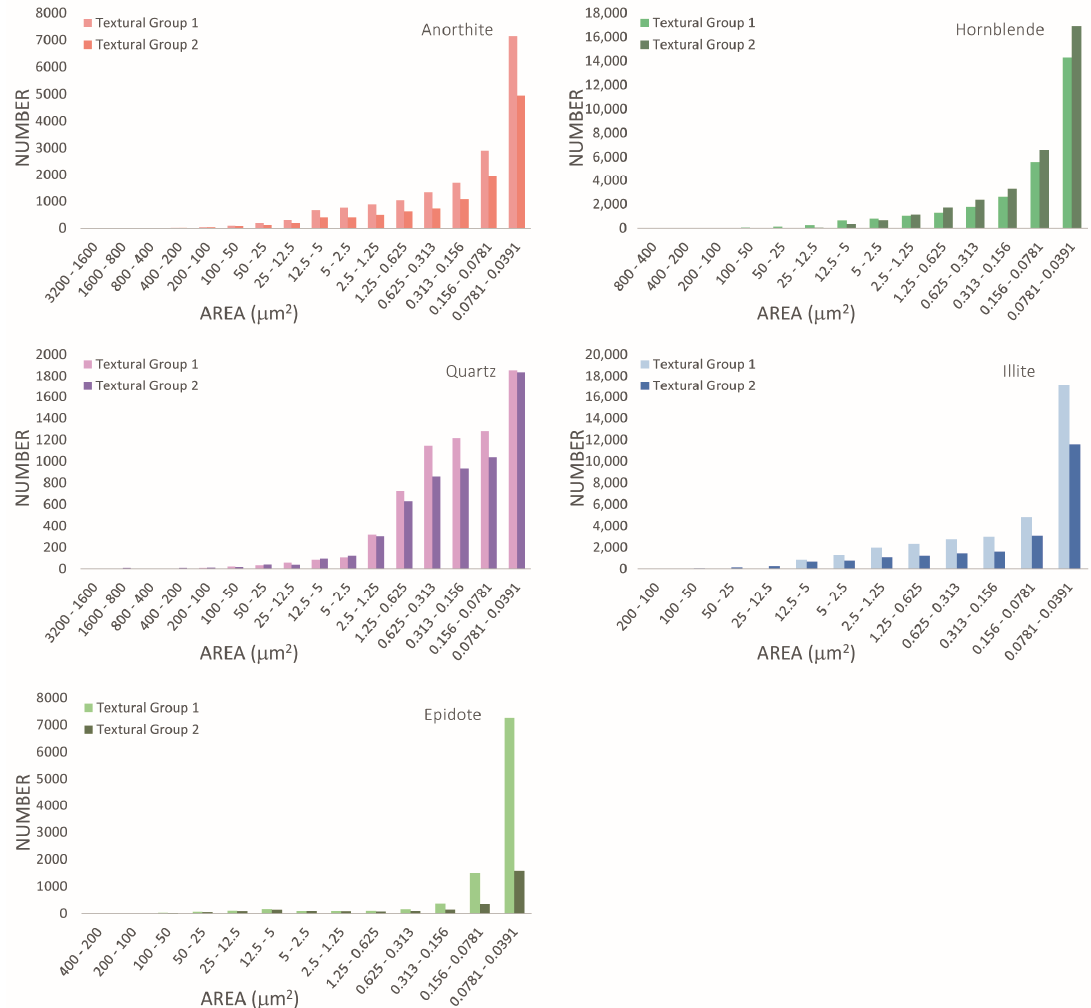
Figure 6. Grain size distribution for anorthite, hornblende, quartz, illite, and epidote in the analyzed fault gouge for textural groups 1 (TG1) and 2 (TG2). The distribution is shown as grain area in µ m 2 and was measured as a 2D grain size distribution. Most grains are in the smallest bin that corresponds to grain diameters down to 200 nm.